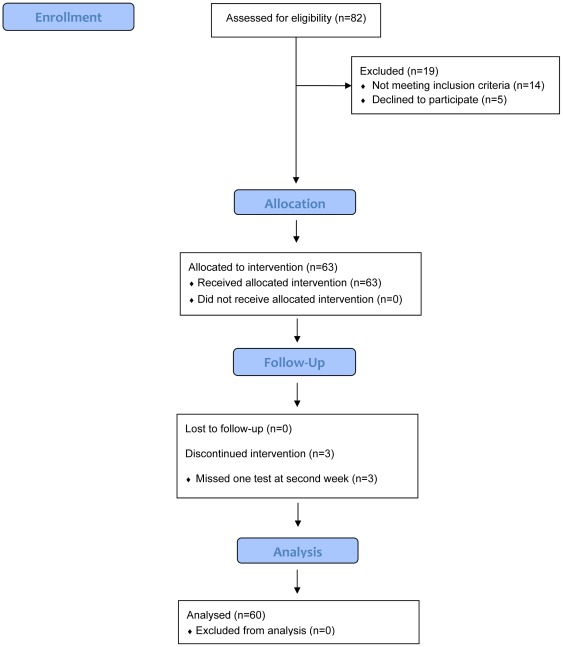
Flow chart of the study protocol.